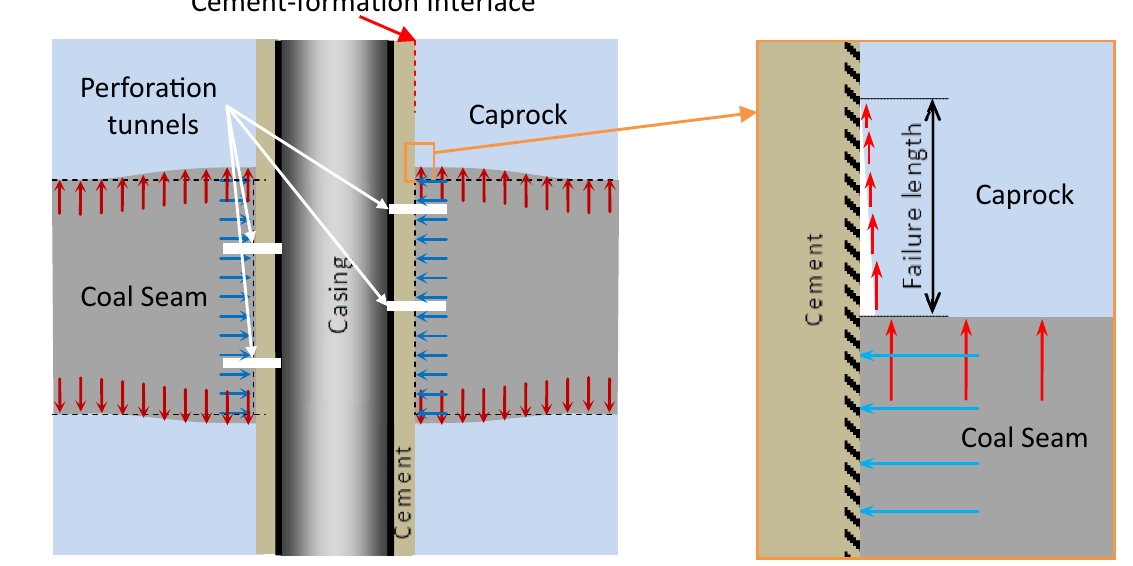
Fig. 1 Location conditions of the casing, cement, interface, caprock and coal